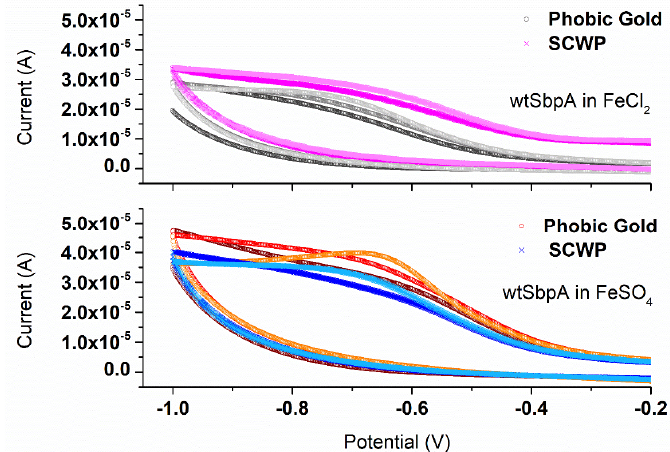
Figure A6. Comparison between the Cyclic Voltammograms (negative range) obtained from SbpA Figure A6 films built in the presence of either FeCl 2 (top) or FeSO 4 (bottom), when the underlying substrate was changed from octanethiol-coated to a SCWP-coated gold